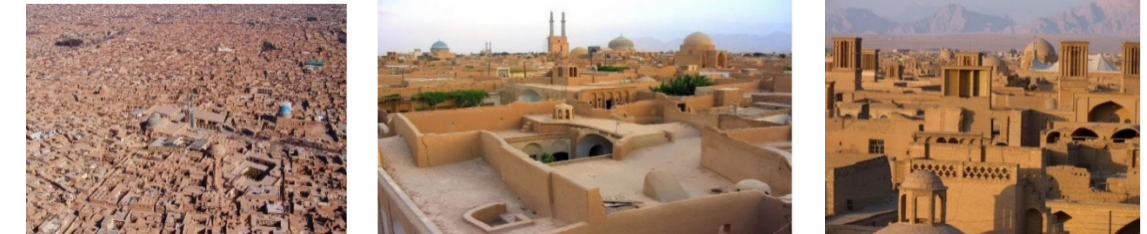
Figure 2. Various shots show details and components of the urban fabric of the old Yazd [33].